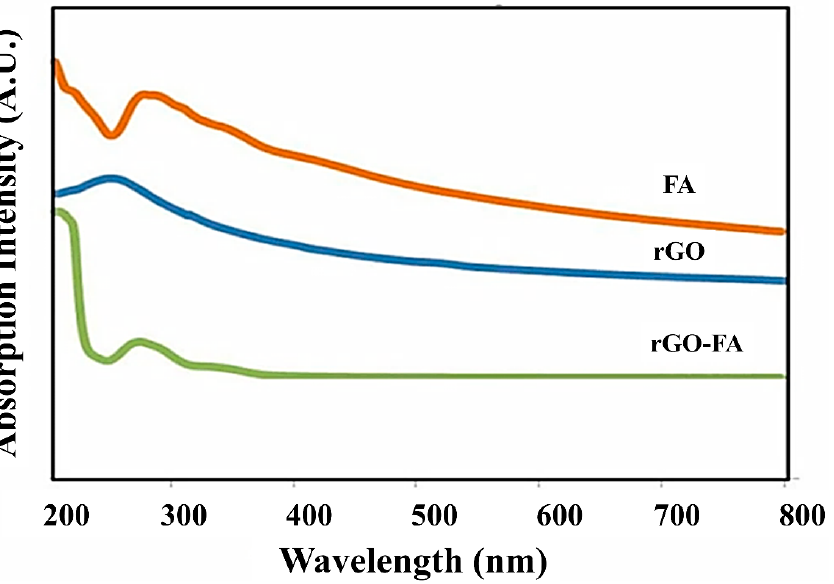
Figure 1. UV-Vis spectroscopic analysis of rGO (0.1 mg/mL), FA (0.1 mg/mL), and FA-conjugated rGO (rGO-FA) (0.1 mg/mL) in aqueous solutions. The red shift of the rGO-FA spectra was ob- served compared to the spectra of rGO and FA alone.